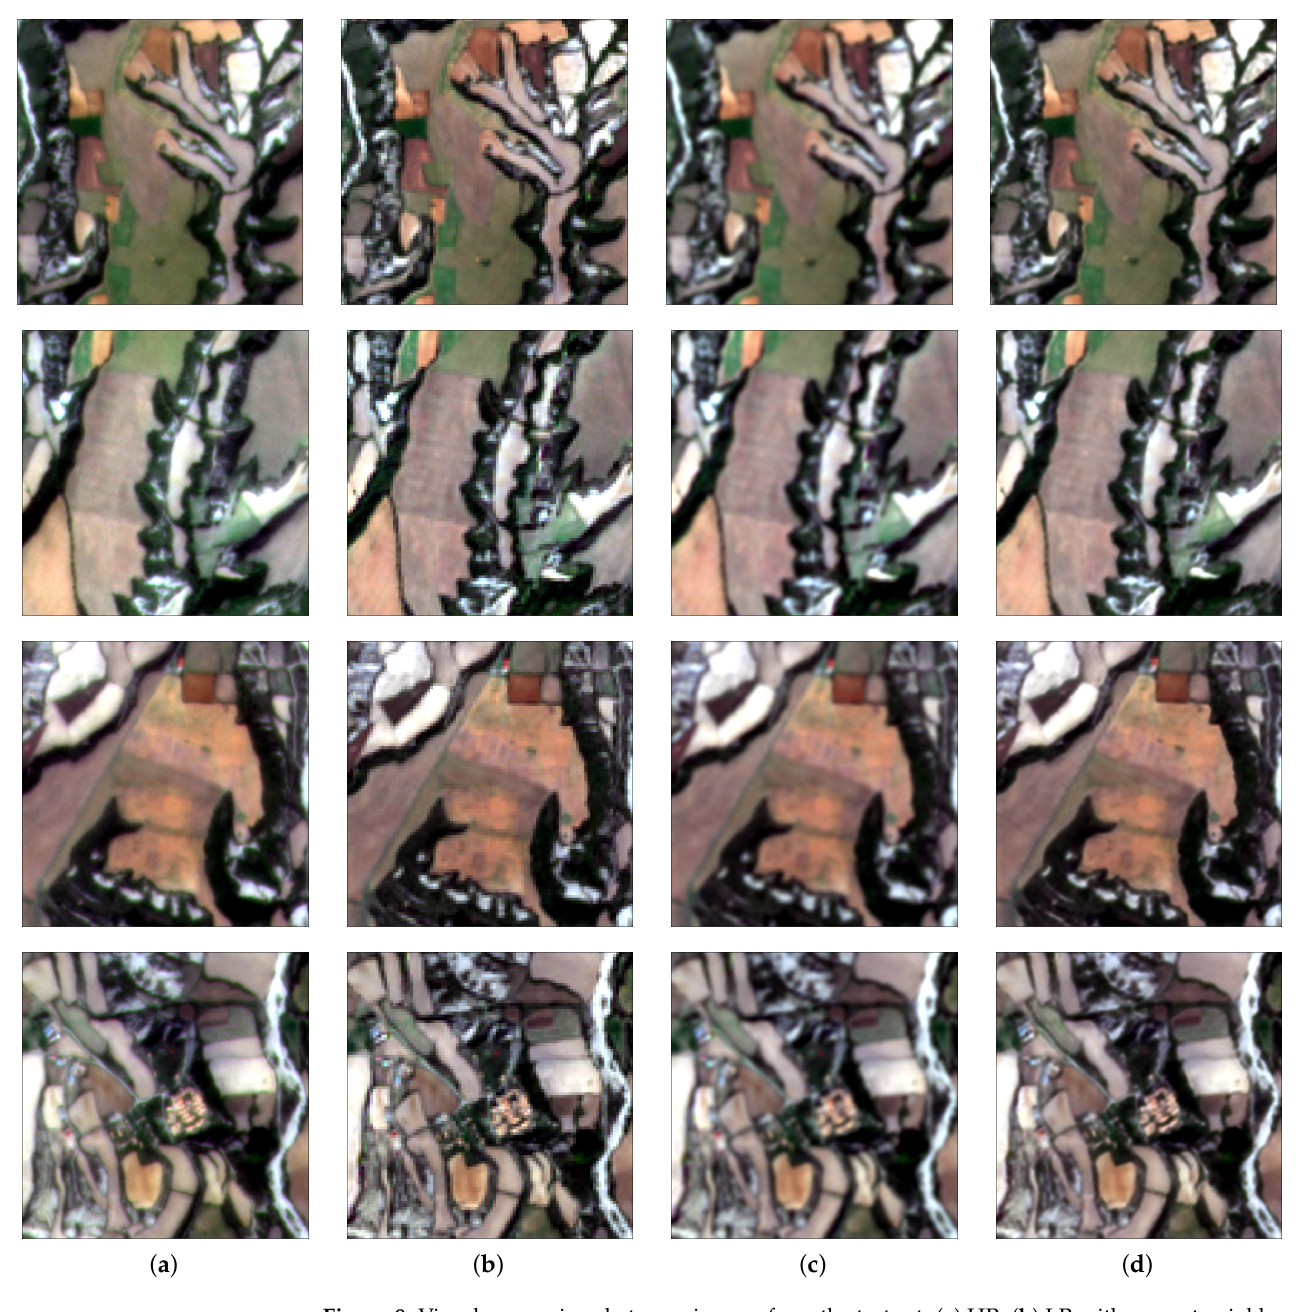
Figure 8. Visual comparison between images from the test set. ( a ) HR; ( b ) LR with nearest neighbour interpolation; ( c ) LR with bicubic interpolation; and ( d ) SARNet8. The results obtained with SARNet8 are clearly